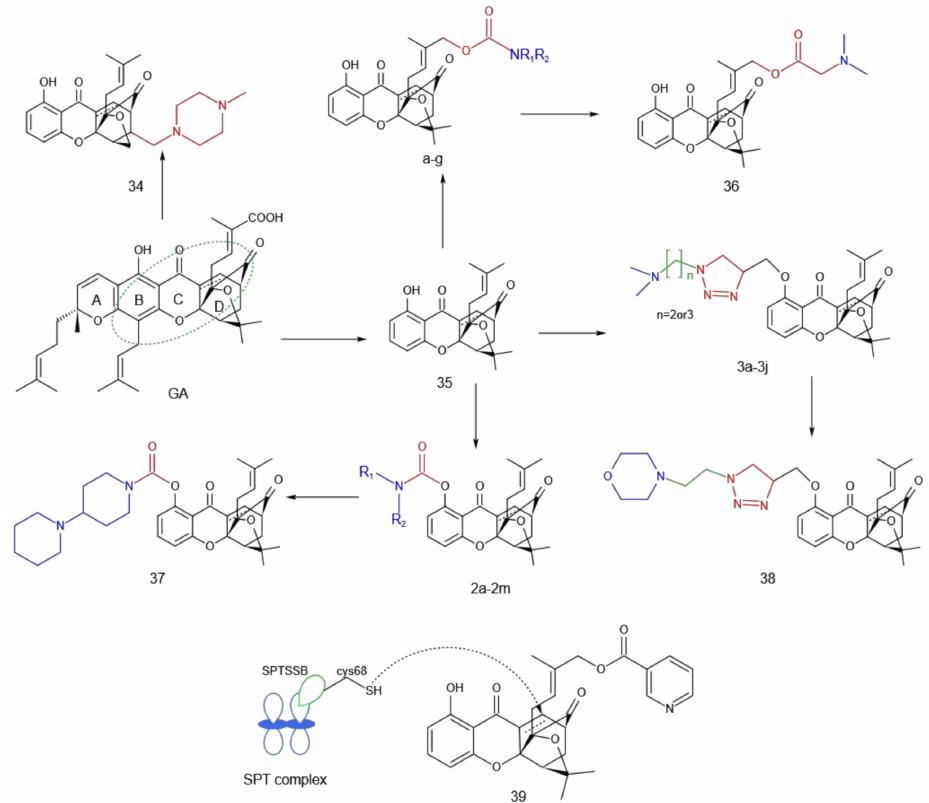
Figure 9. Simplified structure of